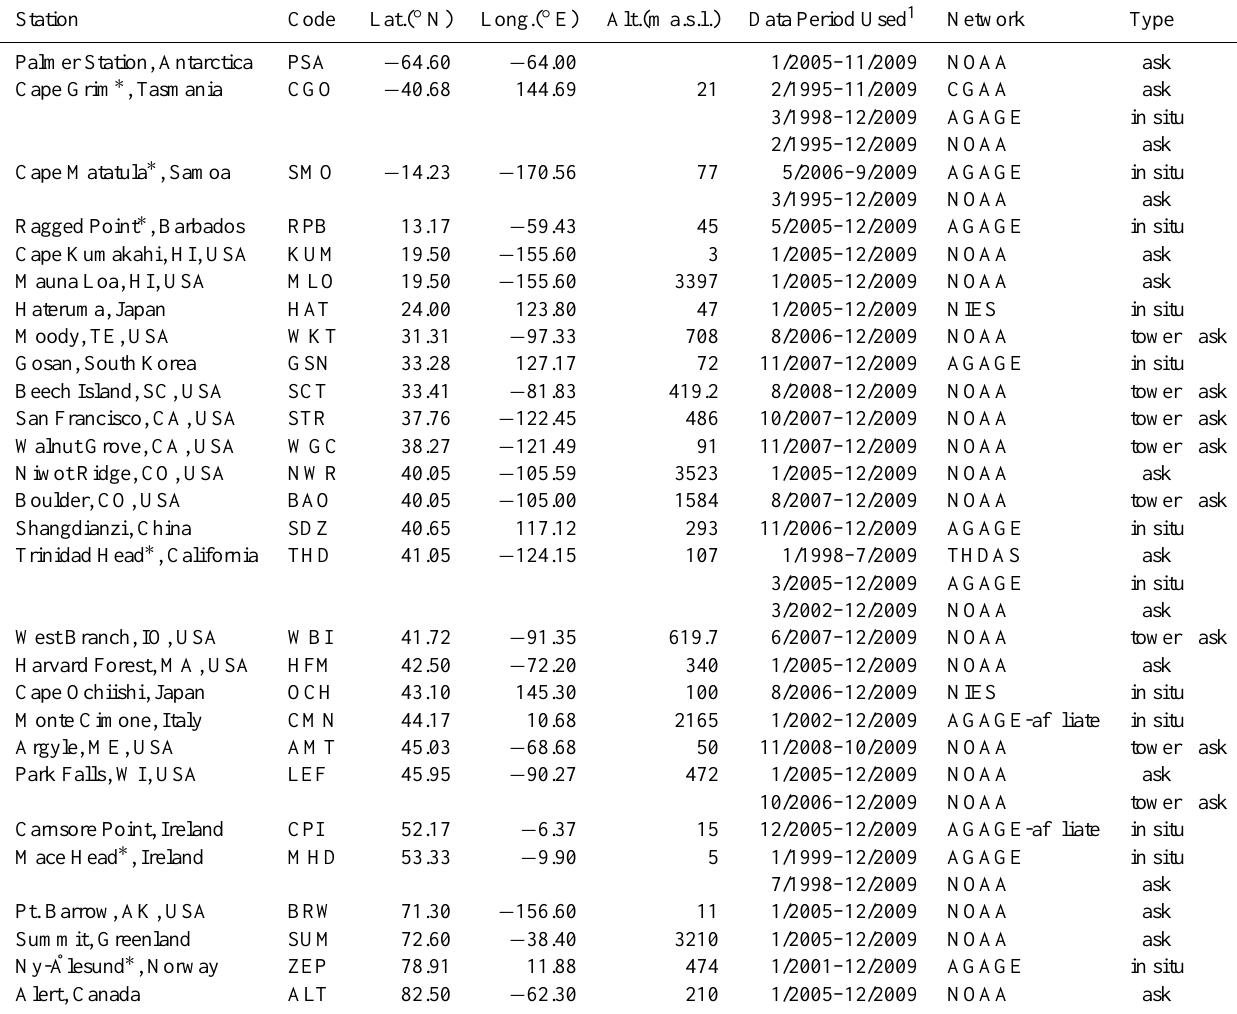
Table 1. HCFC-22 measurement site information. Stations marked with an asterisk are referred to as “background” in the text used for the global